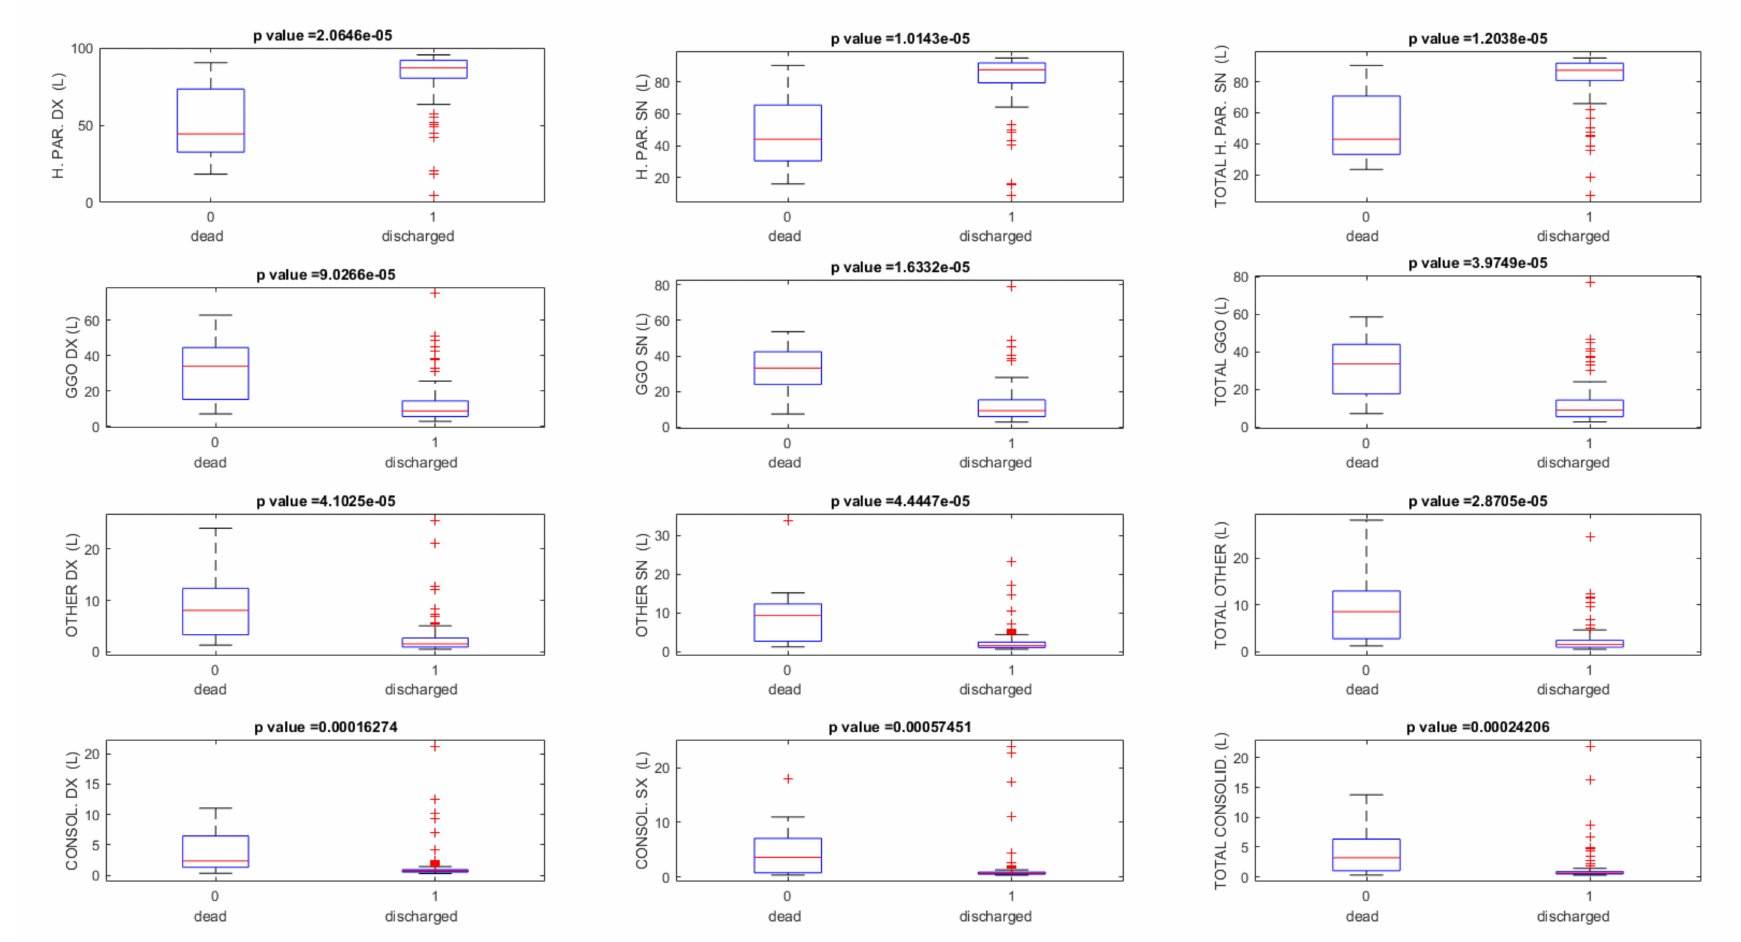
Figure 2. Boxplots of the quantified volume considering dead patients and discharged patients. Note: H. PAR. = healthy parenchyma, GGO = ground glass opacity; CONSOL = consolidation; R = right; L =